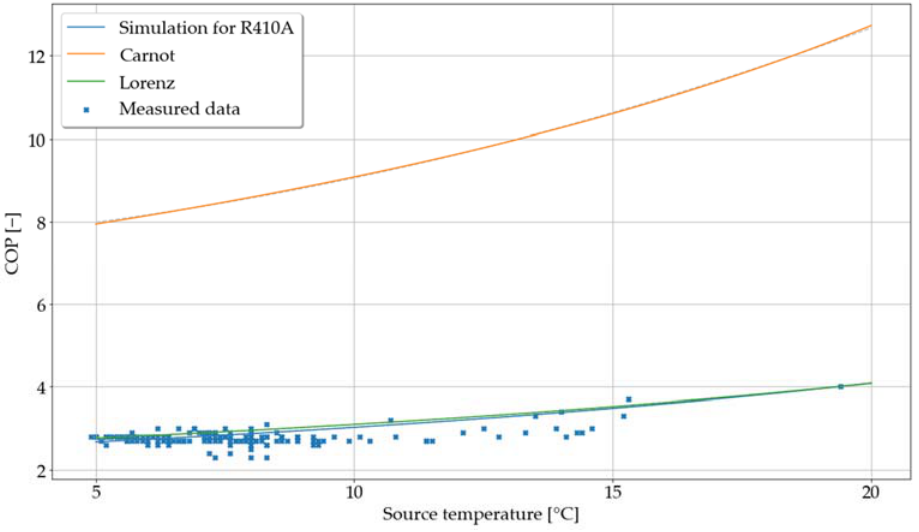
Figure 7. COP results for sink temperature = 45 °C.